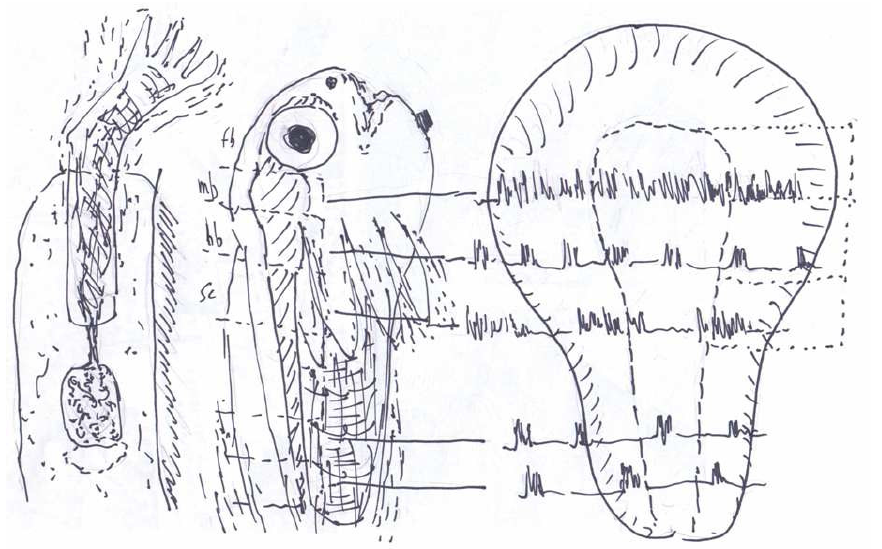
Figure 1. Sketch made for a lecture in 1961 at the Zoology department, Columbia University (New York City) showing: left— the limb/nerve deplantation experiment of Paul Weiss in the axolotl dorsal fin; middle— a frog tadpole showing the transections made at different CNS levels; right— outline of the early anuran neural plate illustrating the spontaneous motility patterns generated by isolated presumptive CNS fragments combined with mesoderm (see text and [6] for